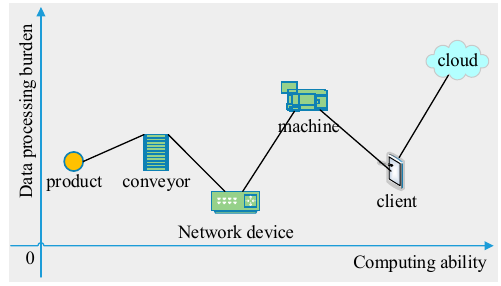
Figure 2. Relative computing ability and data processing burden of the smart factory components.